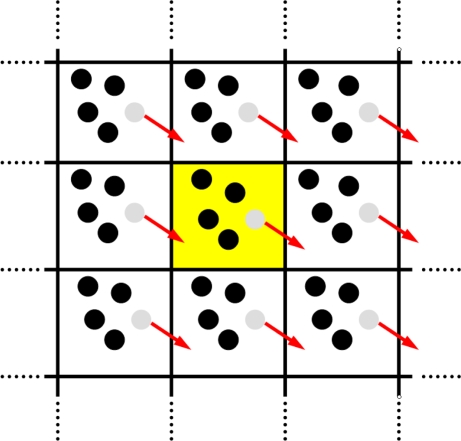
Two-dimensional schematic of periodic boundary conditions. The particle trajectories in the central simulation box are copied in every direction.